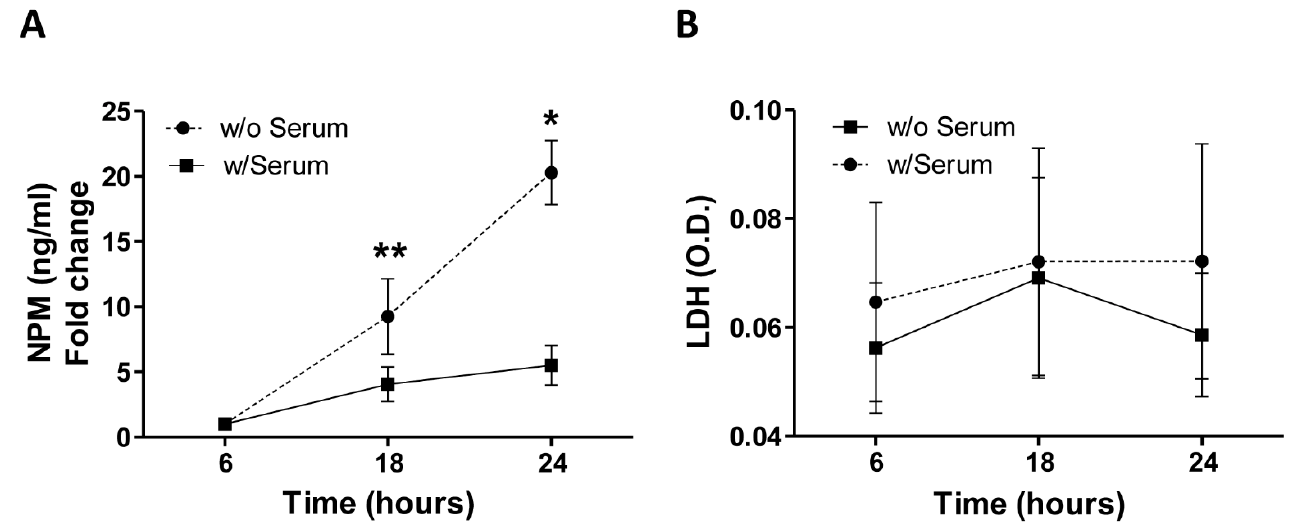
Figure 2. ( A , B ). Secretion of NPM by HUVEC in serum starvation conditions and in absence of cell necrosis. ( A ) Active release of NPM into the microenvironment of HUVEC according to a time course (6, 18, 24 h) of serum deprivation (w/Serum) and measured by ELISA, showing a gradual increase of the protein in the culture media of endothelial cells at 18 and 24 h compared to 6 h. Data are the results of 4 independent experiments (technical duplicates). * p < 0.05, ** p < 0.01. ( B ) Concentration of the enzyme lactate dehydrogenase (LDH) displaying the absence of cell necrosis in both conditions (with Serum, w/Serum and without Serum, w/o Serum). Data are the results of 3 independent experiments (technical duplicates). O.D. optical density.